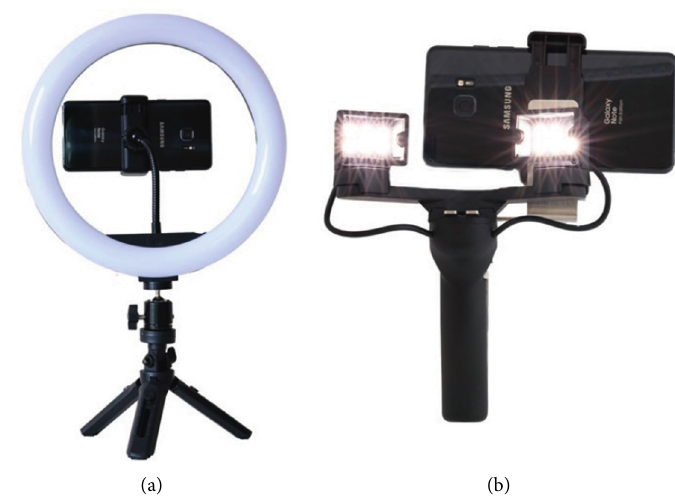
Figure 4: LED ring light (a) and intraoral LED light